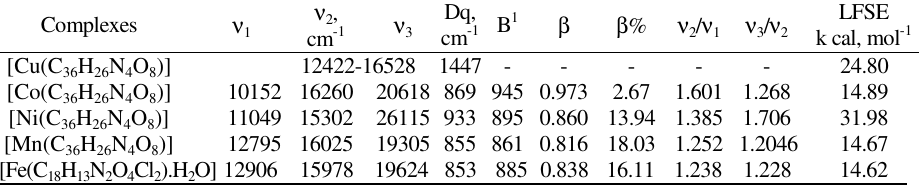
Table 2. Electronic spectral data, ligand field parameters of Cu(II), Co(II) Ni(II), Mn(II) and Fe(III) coumarin